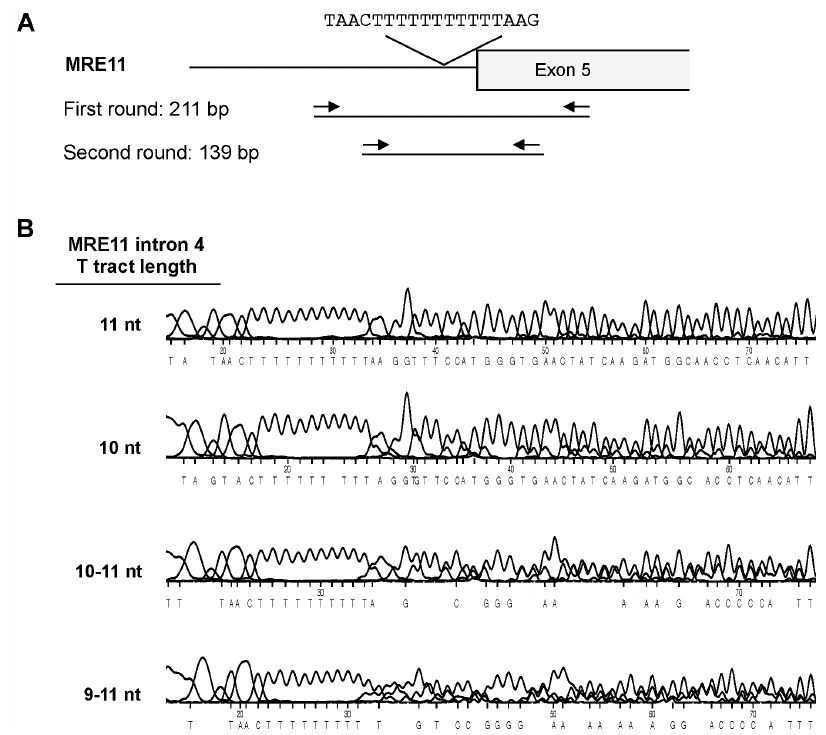
Figure 2. Genomic PCR assay of MRE11 intron 4 T 11 tract. (A) Diagram of the MRE11 intron 4/exon 5 junction, showing the T 11 tract in intron 4, flanking sequence and primers. Contraction of the T 11 tract impairs the lariat formation step in mRNA splicing and leads to skipping of exon 5. The resulting mutant mRNA encodes a truncated MRE11 polypeptide with potentially dominant negative effect on protein function [12]. MRE11 is essential for cell viability, and the MRE11 mutations that occur in MMR-D CRC are not null alleles but reduce expression and activity of the MRE11 protein. (B) Sequence traces of the region of MRE11 intron 4 that carries the T 11 tract in four tumor samples. Lengths of tracts in nt shown at left. doi:10.1371/journal.pone.0108483.g002 PLOS ONE |